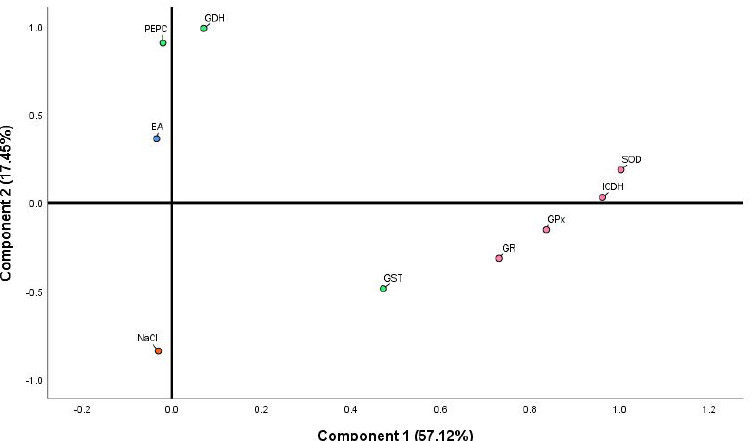
Figure 4. PCA to understand treatment-variable relationships for antioxidant enzyme activity of wheat plants. Abbreviations are as follows: Superoxide dismutase (SOD), Isocitrate dehydrogenase (ICDH), Glutathione peroxidase (GPx), Glutathione reductase (GR), Glutathione S-transferase (GST), Glutamate dehydrogenase (GDH), Phosphoenolpyruvate carboxylase (PECP), Algal extract (EA), Sodium chloride (NaCl).